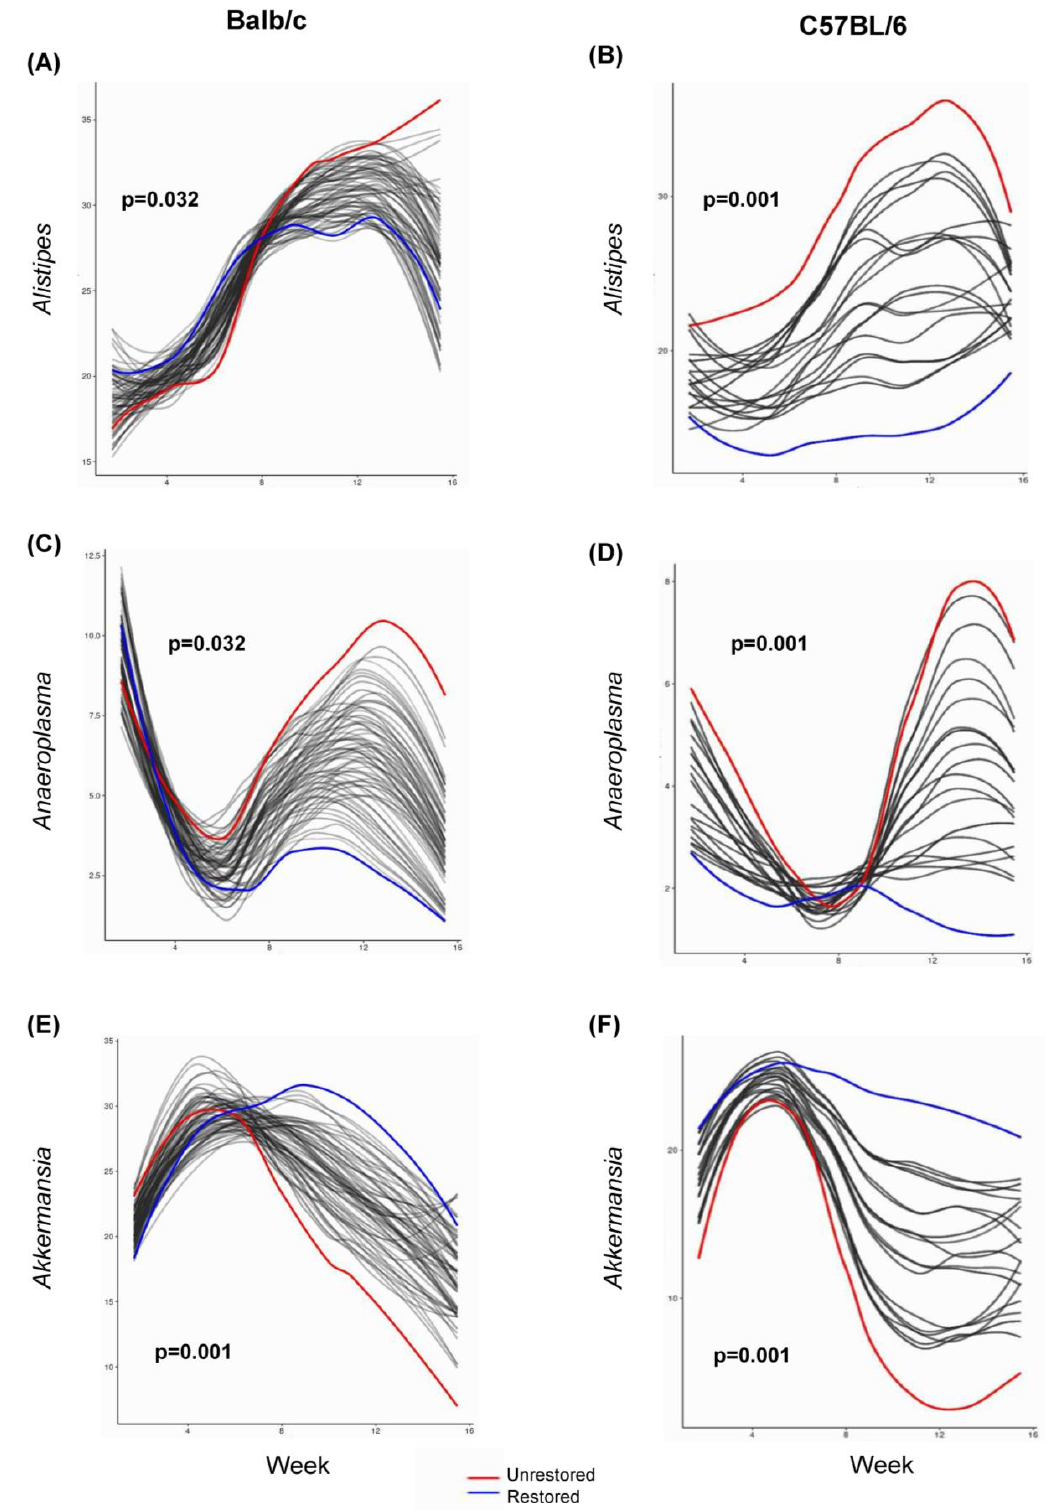
Figure 5. Longitudinally significant genera conserved between mouse genotypes. Longitudinal differences in the relative abundance of genera significantly differ between no restoration (red) and restoration (blue) groups as determined by SplinectomeR. ( A ) Alistipes, Balb/c ( p = 0.032); ( B ) Alistipes, C57BL/6 ( p = 0.001); ( C ) Anaeroplasma, Balb/c ( p = 0.032); ( D ) Anaeroplasma, C57BL/6 ( p = 0.001); ( E ) Akkermansia, Balb/c ( p = 0.001); ( F ) Akkermansia, C57BL/6 ( p =